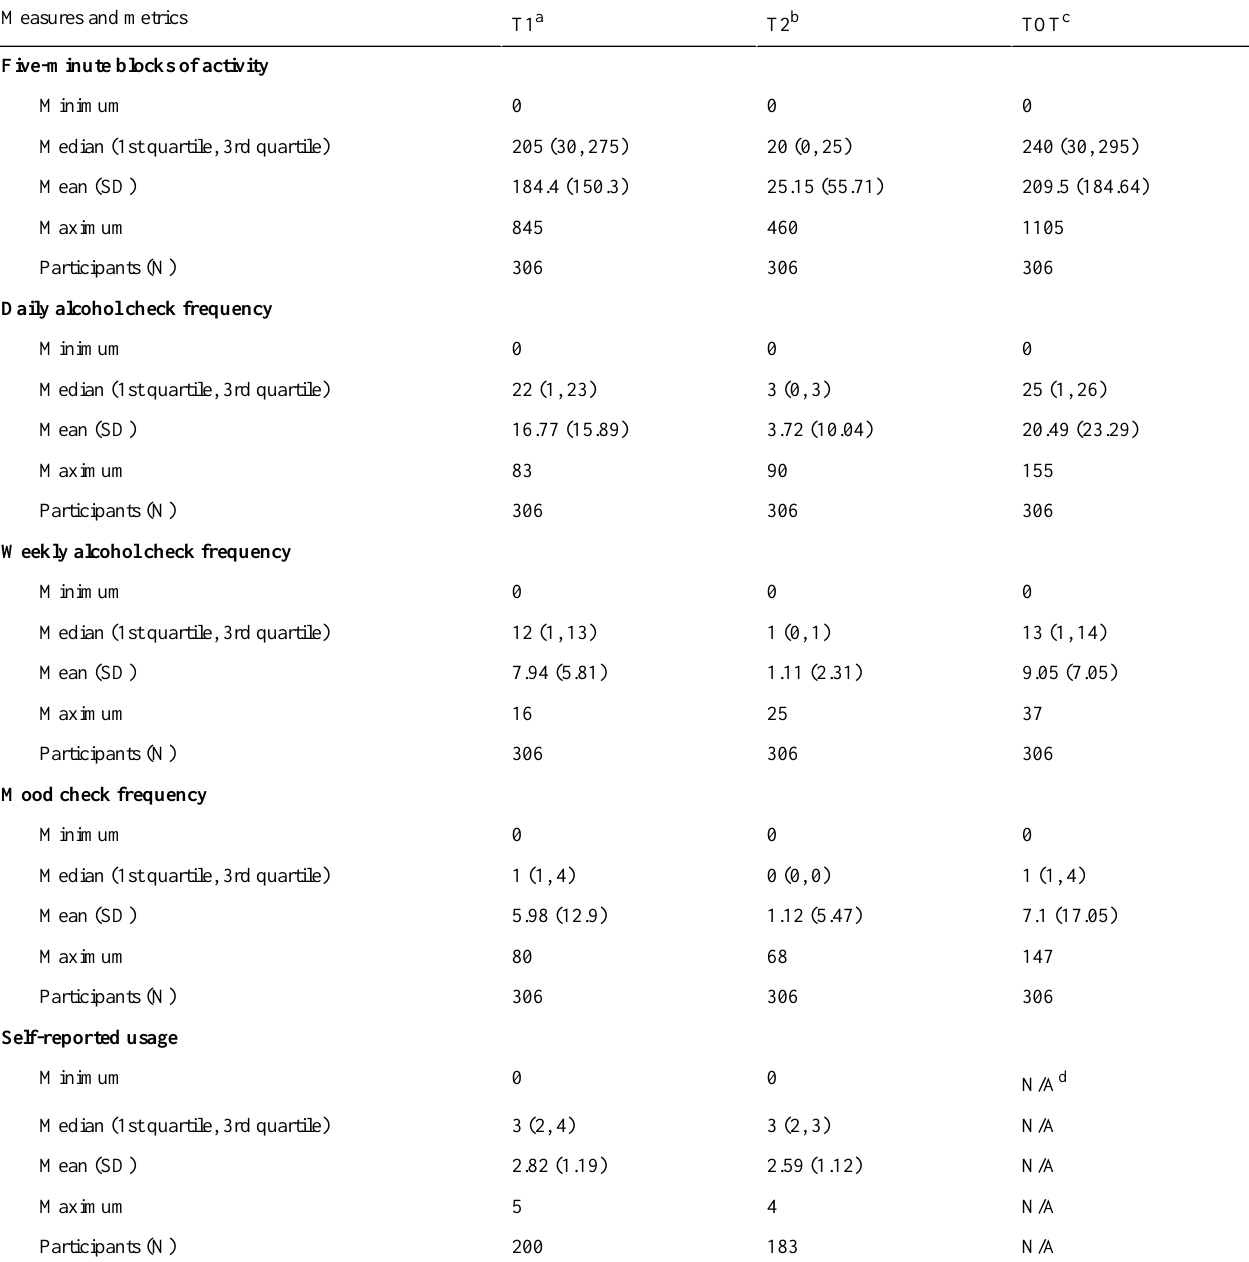
Table 2. Overview of the engagement with the digital behavior change intervention as captured by all measures available.